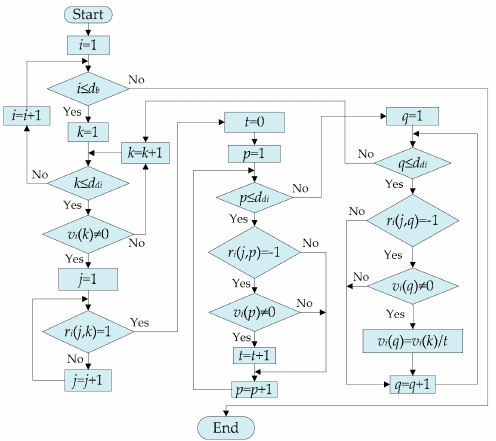
Figure 8. The algorithm to modify the v i .